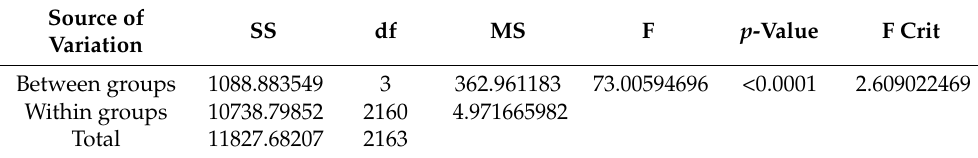
Table 6. Summary of ANOVA results for simulated occupancy for four typical teaching and learning activities in the same room, with contact time